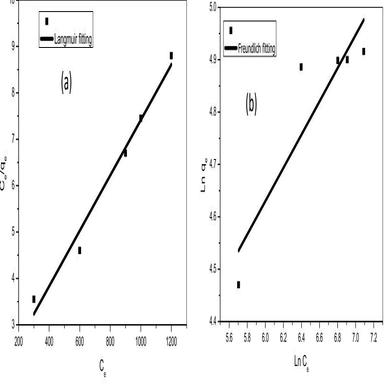
Adsorption isotherm for the sorption of Mo(VI) onto mesoporous MnO2/MWCNTs composite using (a) Langmuir model (b) Freundlich model.